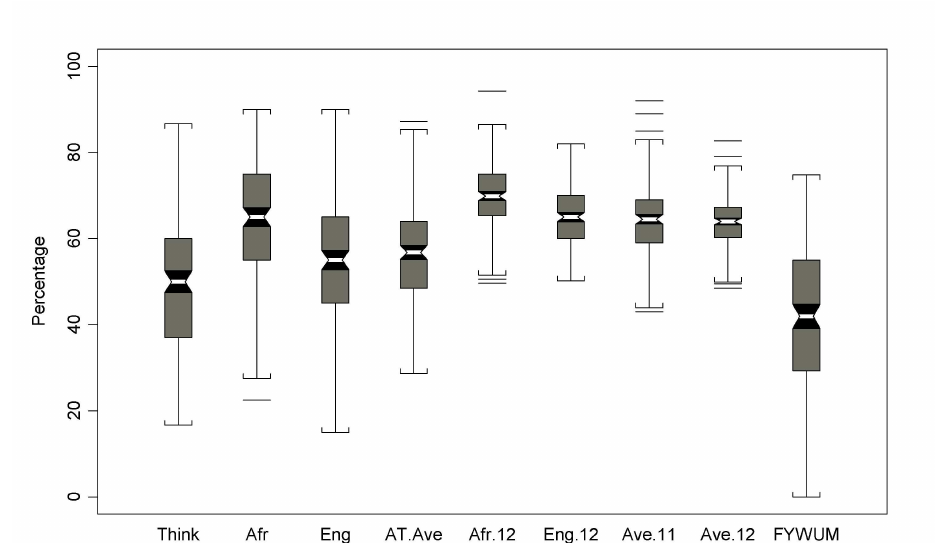
Figure 3: Notched boxplots of the variables of the Test Battery 3 data set for the 2000 intake